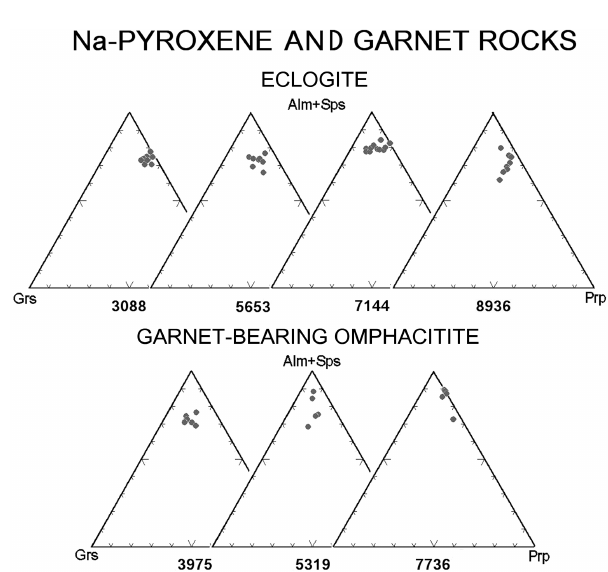
Figure 6. Compositional variation in garnet, plotted in the diagram as almandine (Alm), spessartine (Sps), grossular (Grs), and pyrope (Prp) in Na pyroxene and garnet rocks (seven